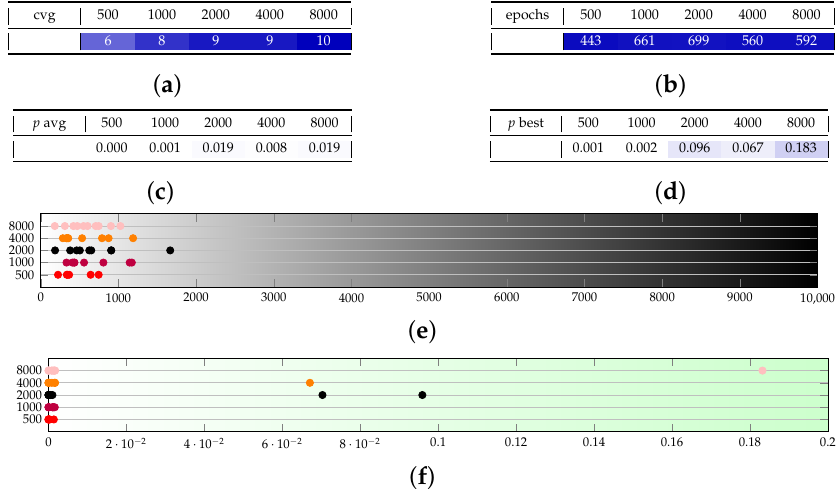
(a) Converging runs, out of 10. (b) Number of epochs before convergence, on average.